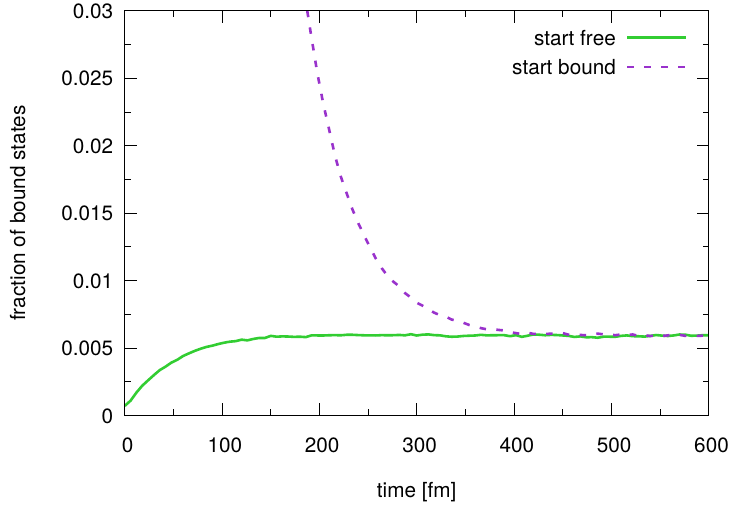
Figure 5. Time evolution of the fraction of bound states with the charm-anticharm pairs produced initially bound (violet dashed line) or placed randomly inside the box (green solid line). Both curves lead to the same equilibrium limit but the equilibration time is longer in case of initial bound